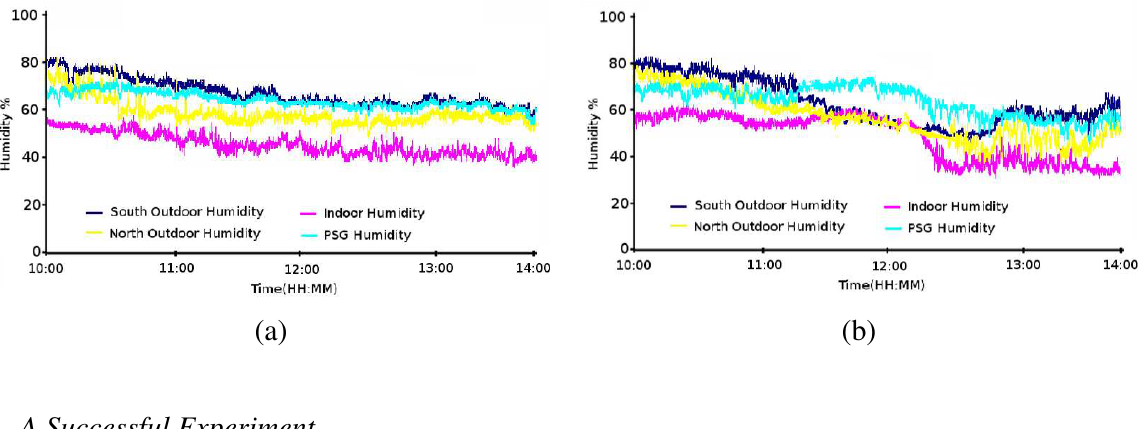
Figure 12. Humidity measurements (a) for a normal working day and (b) when the water pipe broke